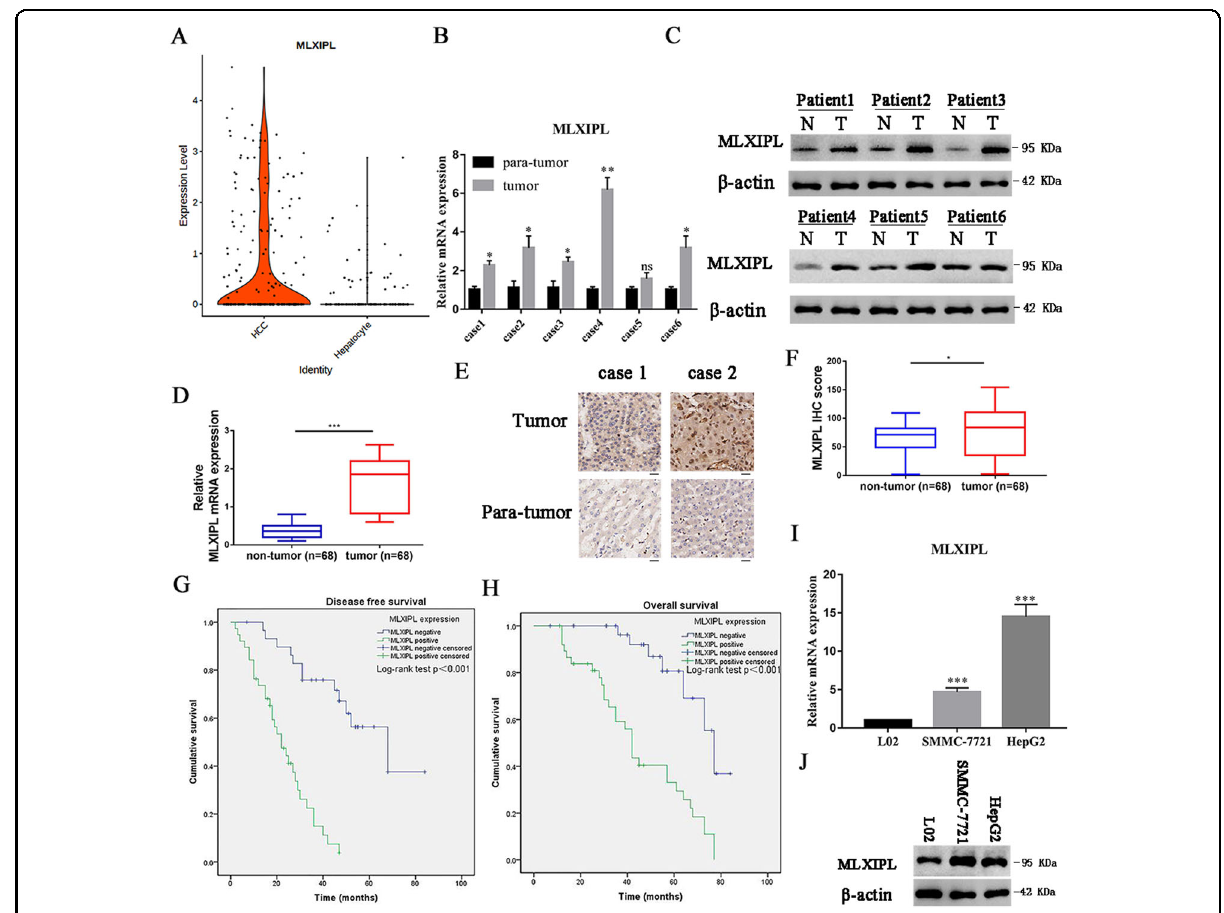
Fig. 5 MLXIPL, as a potential biomarker, is correlated with a poor survival rate of HCC patients. A A violin plot revealed the mRNA level of MLXIPL in HCC clusters comparing to hepatocyte clusters. B , C Quantitative real-time PCR and western blotting analysis were performed to detect MLXIPL protein expression in six patients of HCC and para-tumor tissues used in single-cell sequence. ns P > 0.05; * P < 0.05; ** P < 0.01. D PCR analysis were performed to detect MLXIPL mRNA expression in 68 patients of HCC and para-tumor tissues used in single-cell sequence. *** P < 0.001. E , F Representative immunohistochemistry pictures and IHC score of the MLXIPL protein expression. * P < 0.05. G , H Kaplan – Meier survival curve based on different expression levels of MLXIPL. J MLXIPL expression was signi fi cantly increased in HCC cells compared to L02 cells in mRNA level. *** P < 0.001. I MLXIPL protein was relatively overexpressed in HCC cells compared to L02 cells in protein